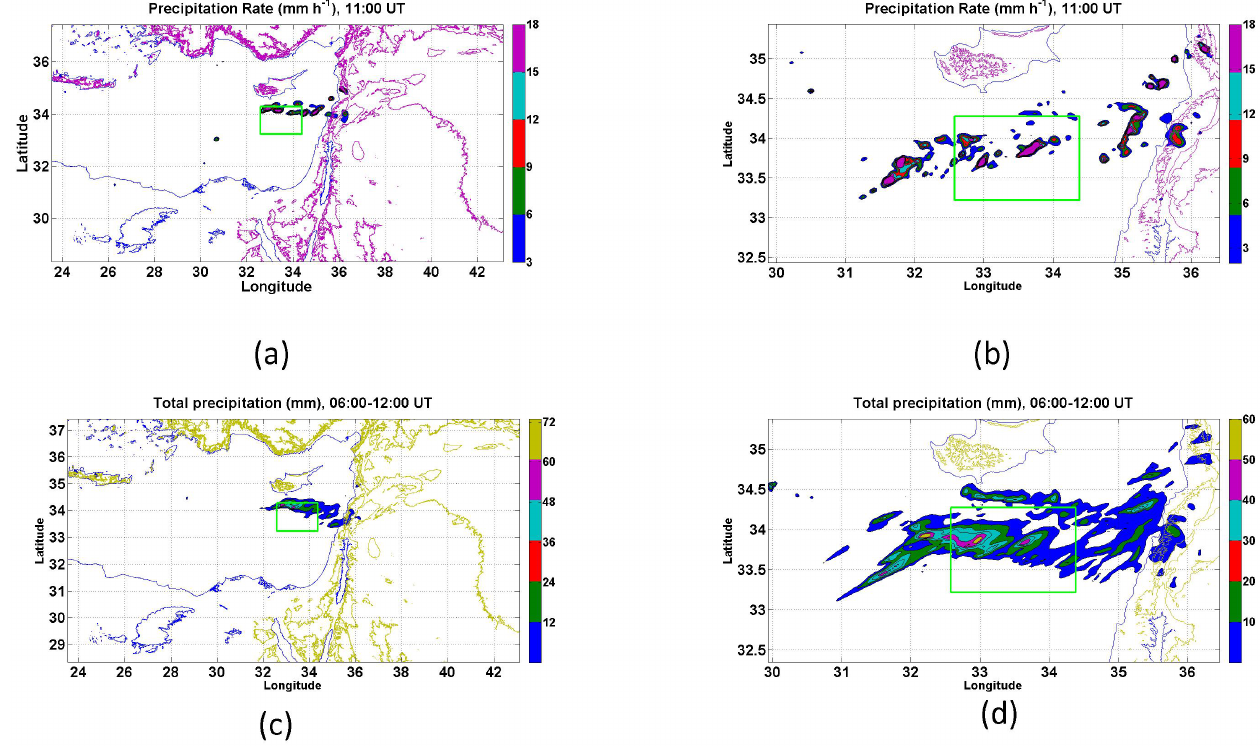
Fig. 3. Precipitation rates (in mmh − 1 ) at 11:00UT and total precipitation between 06:00 and 12:00UT for the two external domains, (a) and (b) – Precipitation rates, (c) and (d) – Total precipitation. The green rectangle marks the area in which detailed simulations of the cloud microphysics were carried